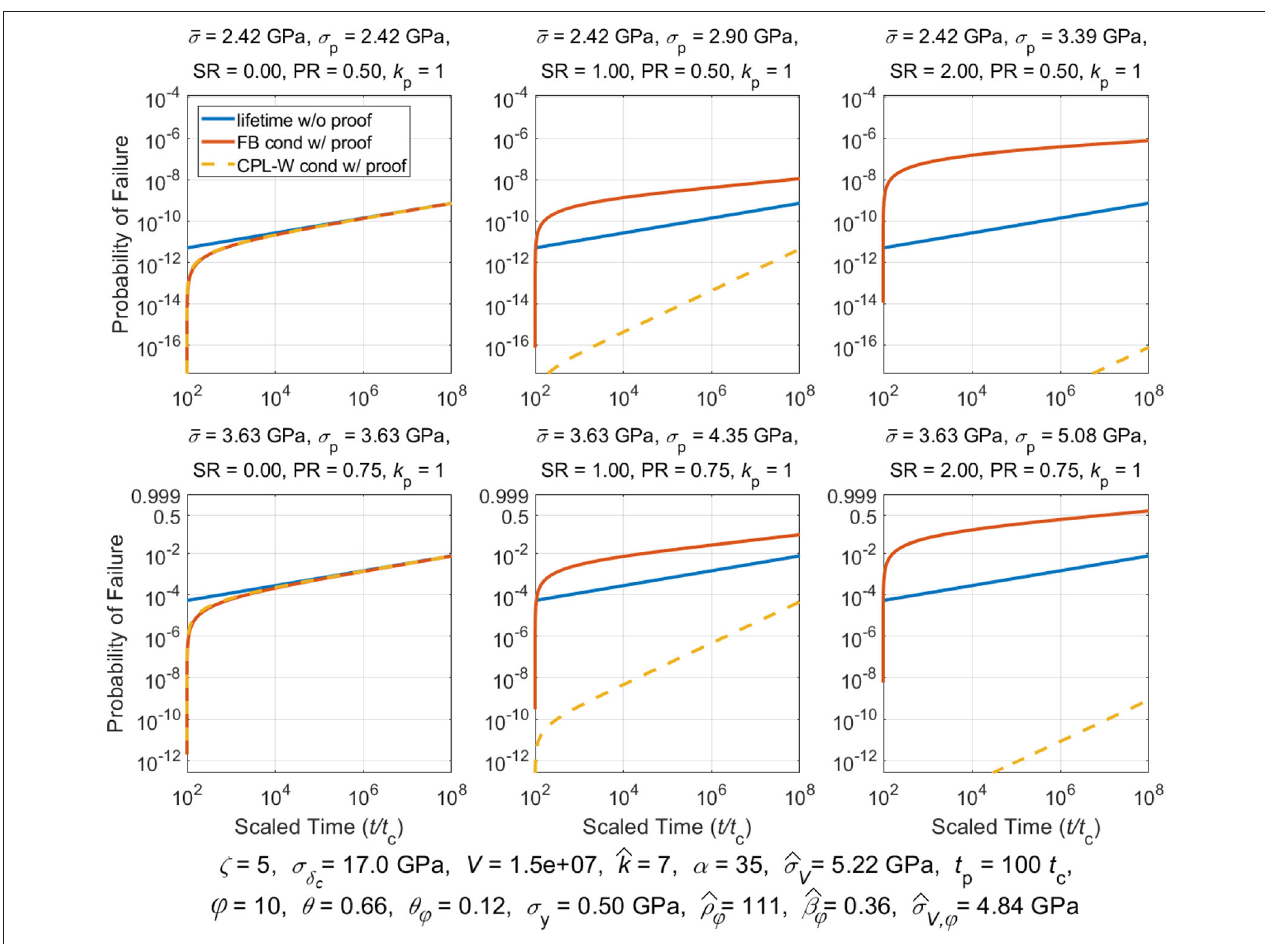
Frontiers in Physics |